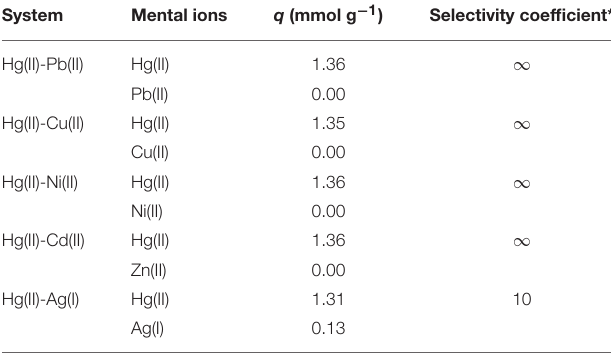
TABLE 5 | Adsorption selectivity of PPTA-AM-70 toward Hg(II) at 25 ◦ C (pH 5.0).